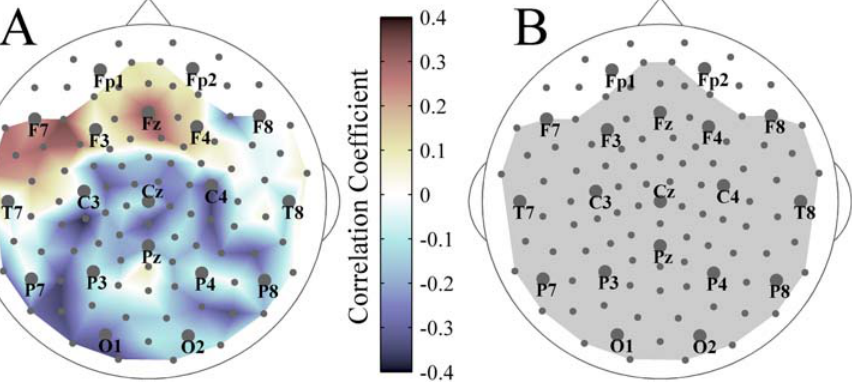
Figure 7. Relationship between synchronization and power. A: Correlation map between the relative changes of S-estimator and the relative changes of power for patients. The correspondence between color and correlation strength is shown by the scale bar. B: Significance map for the correlations shown in A; color convention is as in Fig. 5.